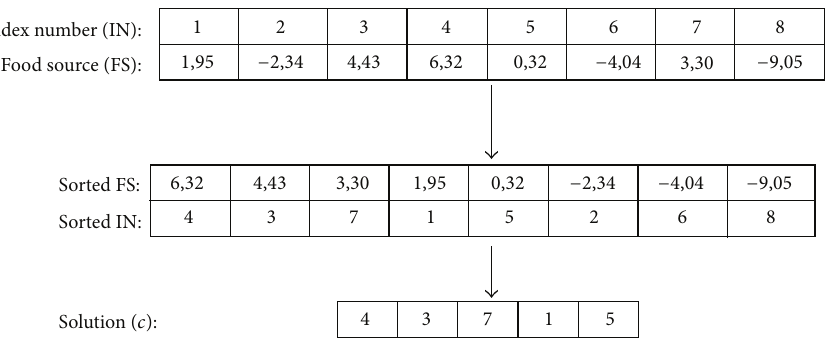
Figure 1: Example of random key-based